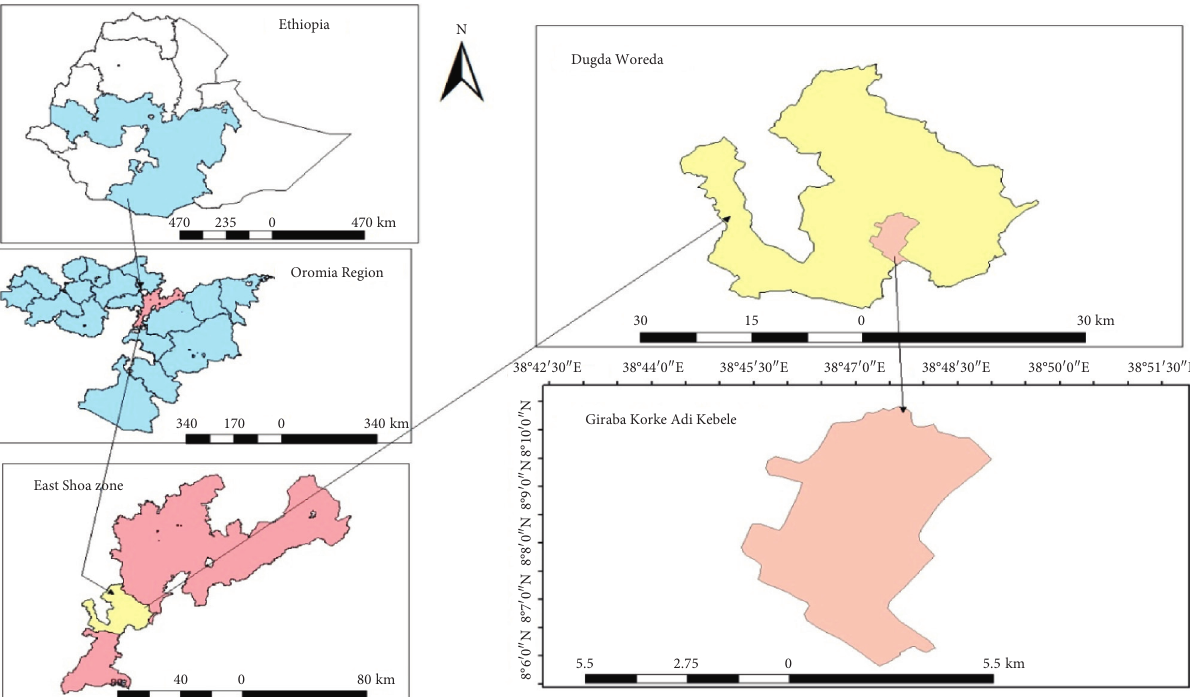
Figure 1: Map of the study